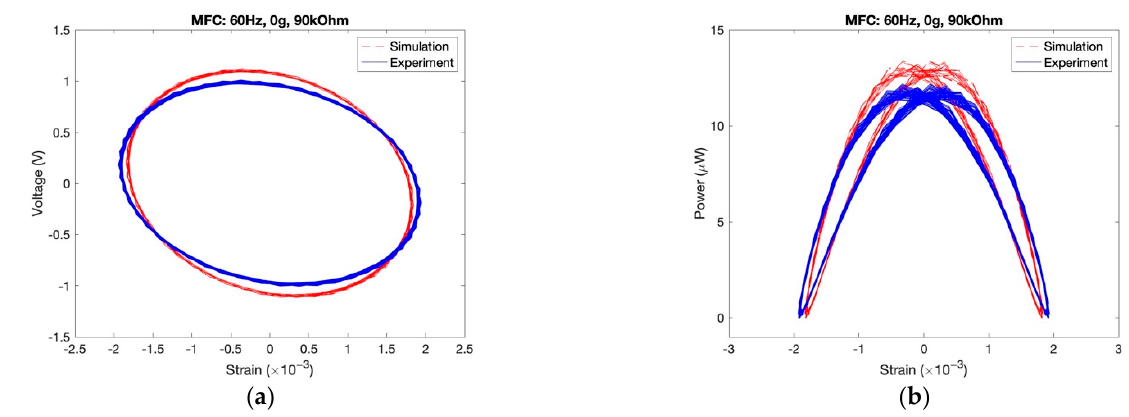
Figure 15. Comparison of experimental and simulation results in MFC. ( a ) Voltage vs. strain; ( b ) Power vs.